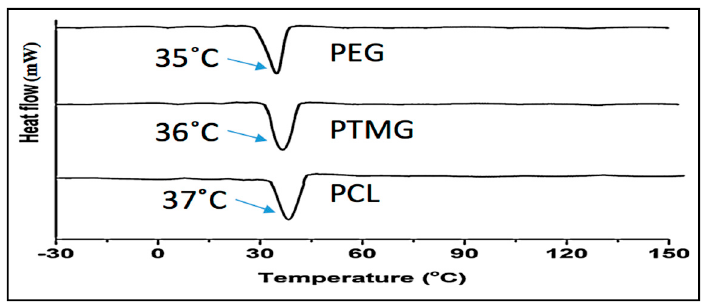
Figure 10. Differential scanning calorimetry (DSC) of different polyurethane.